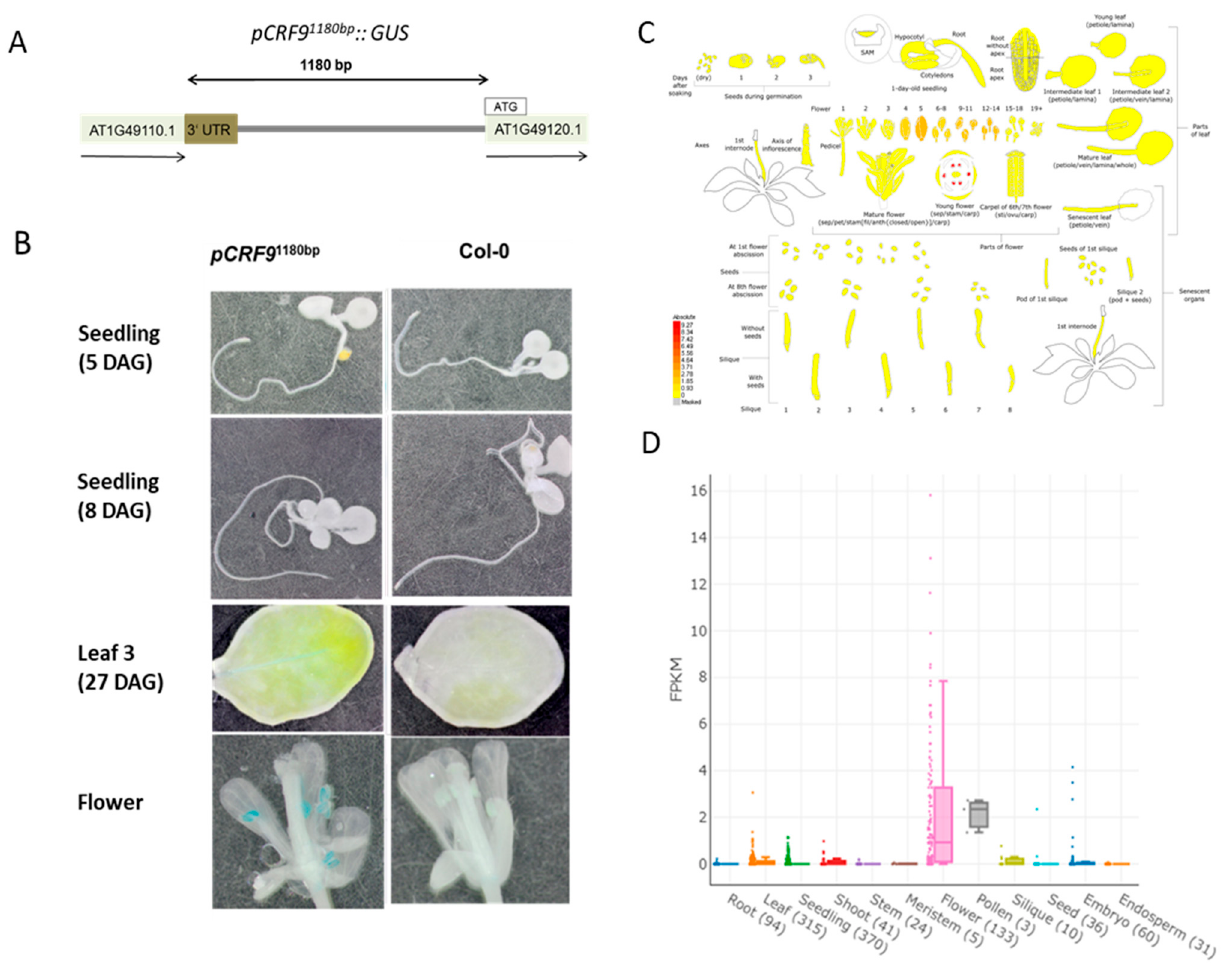
Figure 2. Expression analysis of CRF9. The expression of CRF9 was analyzed. ( A ) Tissue level expression for CRF9 was determined by fusing the promoter (1180 bp upstream of the ATG) to a GUS reporter construct and generating stable transgenic reporter lines. ( B ) Transgenic lines were examined by GUS staining across different stages of development, where the primary expression occurred in flower anthers. ( C , D ) Additional examination of CRF9 expression from RNA-sequencing experiment—The Klepikova developmental data set from eBAR ( C ) and an accumulation of over 20,000+ RNA-seq experiments—the Arabidopsis RNA-seq Database ( D ) also reveal similar patterns of the highest expression occurring in flower anthers and pollen. DAG = Day after germination.